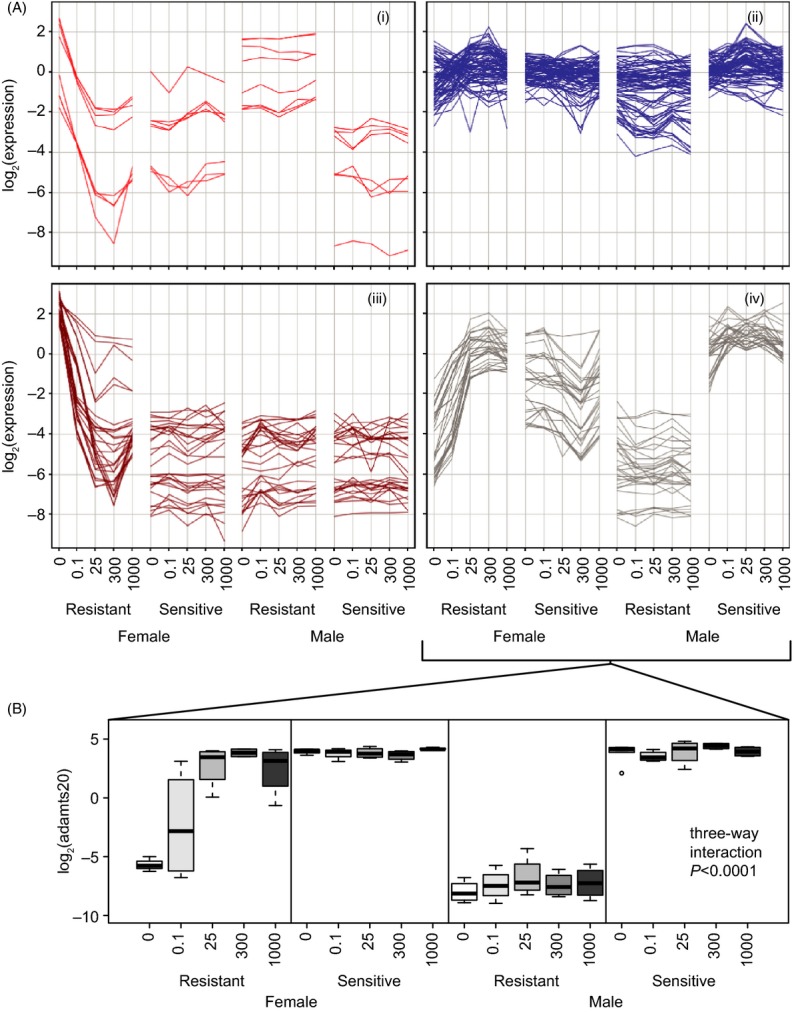
Genes responding to emamectin benzoate (EMB) specifically in resistant females. (A) Genes changing with EMB dose differently depending on sex and population were clustered based on expression into four clusters (i–iv). These genes were mainly comprised of genes responding to EMB exposure in the female resistant population. (B) The expression of a gene within cluster (iv), a disintegrin and metalloproteinase with thrombospondin motifs 20 (adamts20) was confirmed by RT-qPCR.